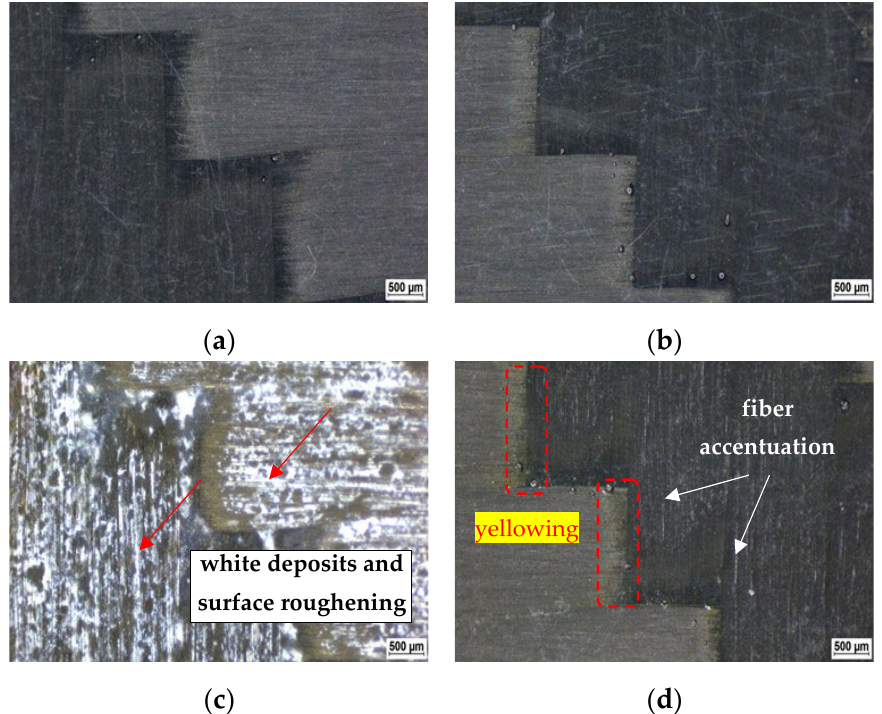
Figure 2. Material surface changes of the experimental CFRP composite; magnification 20× (after 9 weeks); ( a ) reference material before the test; ( b ) after 9 weeks of exposure to 20% NaCl at 60 °C; ( c ) after 9 weeks of exposure to 10% NaOH at 60 °C; ( d ) after 9 weeks of exposure to 15% H 2 SO 4 at 60 °C.